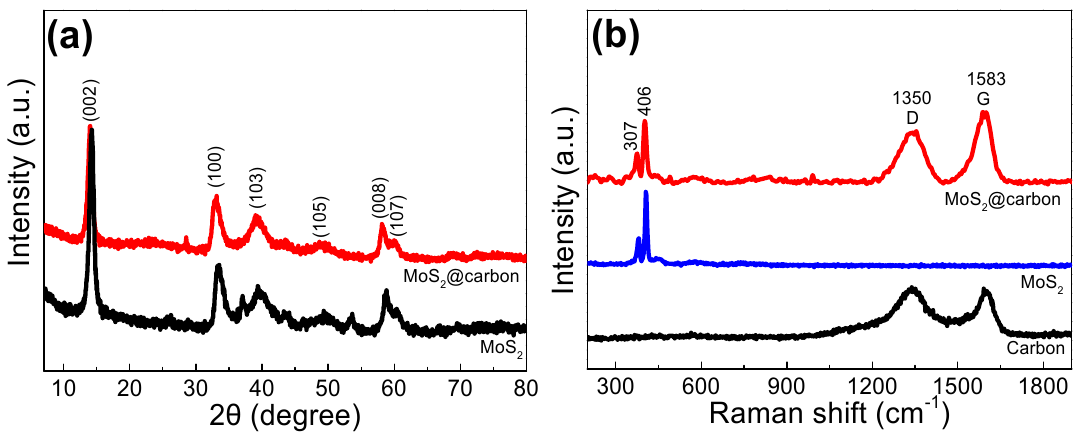
Figure 1. ( a ) XRD patterns of the as-prepared MoS 2 @carbon, pure MoS 2 ; ( b ) Raman spectra of the as-prepared MoS 2 @carbon, pure MoS 2 , and the carbon substrate.